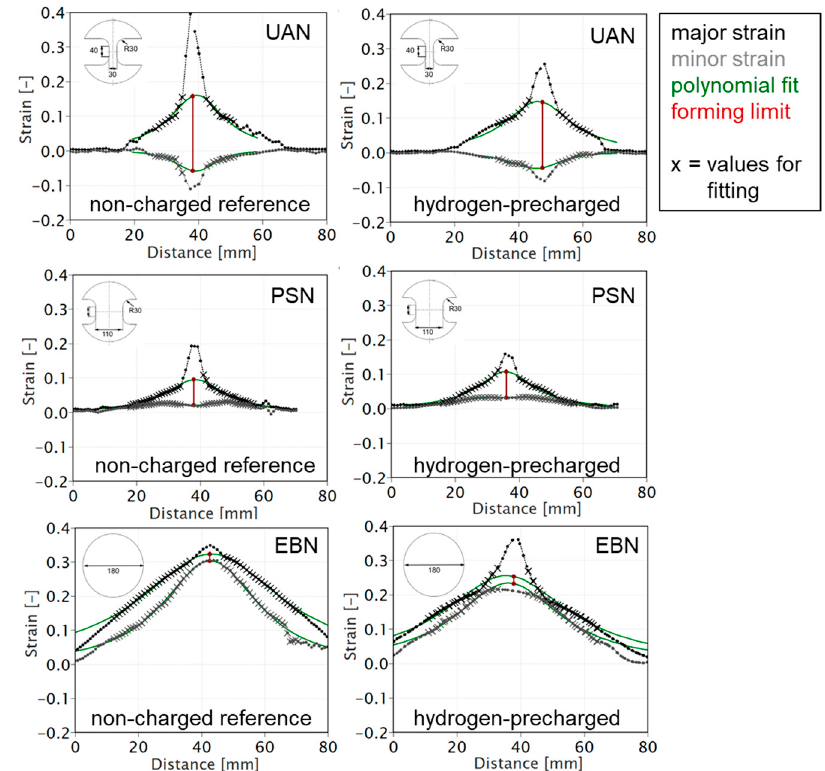
Figure 8. Plot of the major strain (black) and minor strain (gray) over the distance with polynomial fits in green and the forming limits in red. The forming limit was analyzed according to DIN EN ISO 12004-2 [19] for reference and hydrogen-charged Nakajima specimens of CP1000 steel sheets. Experimental values marked with crosses were used for the fitting.